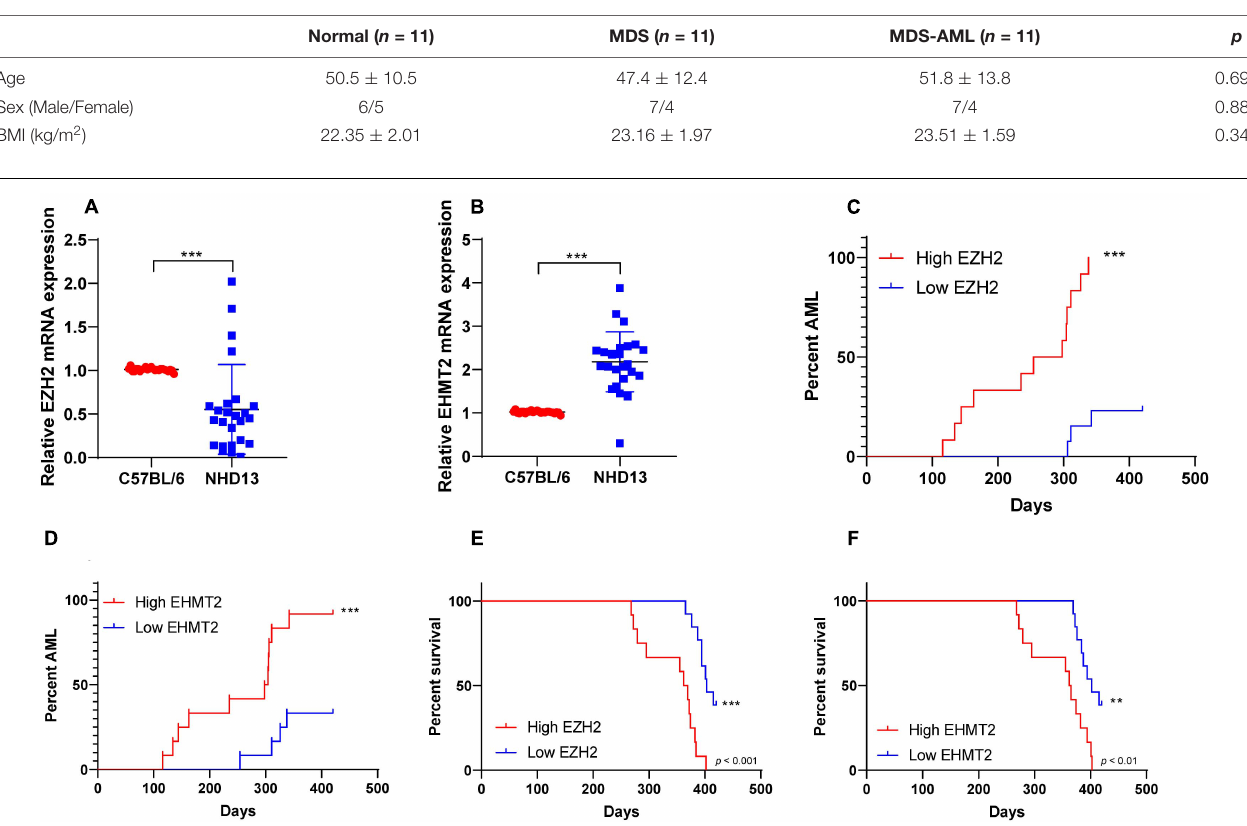
FIGURE 2 | NHD13 mice with high expression of EZH2 transformed into AML more quickly. The survival of NHD13 mice ( N = 25) was observed within 420 days, and the expressions of EZH2 and EHMT2 in peripheral blood of mice were detected at the age of 4 months. NHD13 mice were allocated into high/low expression groups according to the median expressions of EZH2 and EHMT2. (A,B) The expressions of EZH2 and EHMT2 in peripheral blood of mice (at the age of 4 months) were detected using RT-qPCR; (C,D) The number and time of transforming from MDS into AML of NHD13 mice in different groups within 14 months were recorded; (E,F) Survival curves were used to analyze the survival rates of NHD13 mice. Data in panels (A,B) are analyzed using Mann–Whitney U test or t test, and data in panels (C–F) were analyzed using Log-rank test, ** p < 0.01, *** p < 0.001.